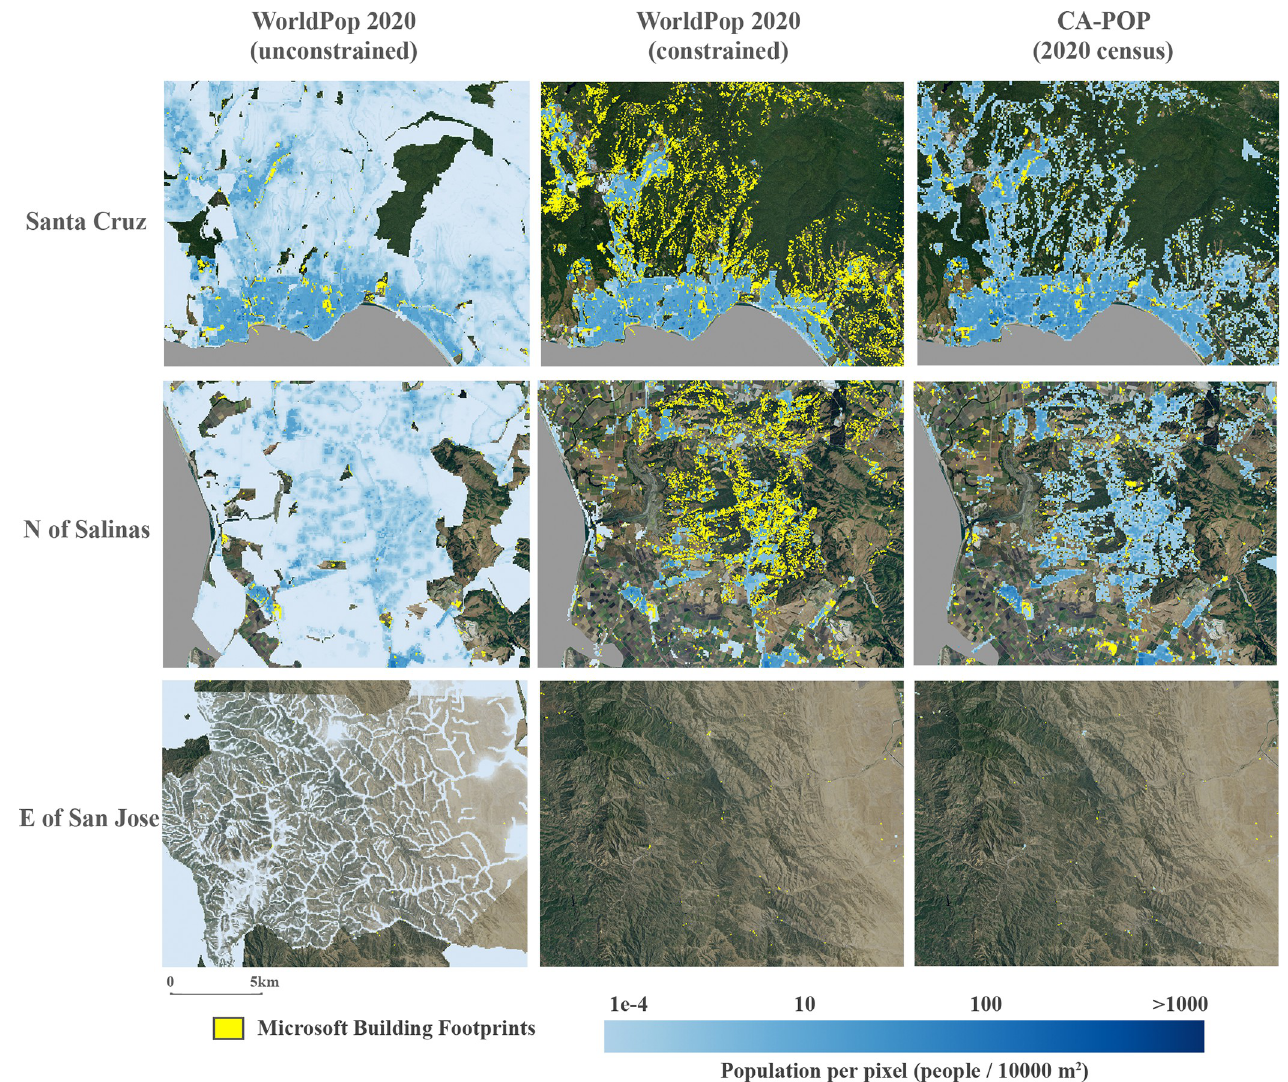
Fig 7. Comparison of CA-POP with the unconstrained and constrained WorldPop grids. Example shown for three locations in California. The first two rows represent populated areas and the third row represents largely unpopulated, open space. Over-apportionment of population across open space is seen in the unconstrained WorldPop grid and under-apportionment to buildings footprints detected by Microsoft (yellow area) in residential parcels is evident in the constrained WorldPop grid, as compared to CA-POP. (Satellite base imagery source: USGS (NAIP) from The National